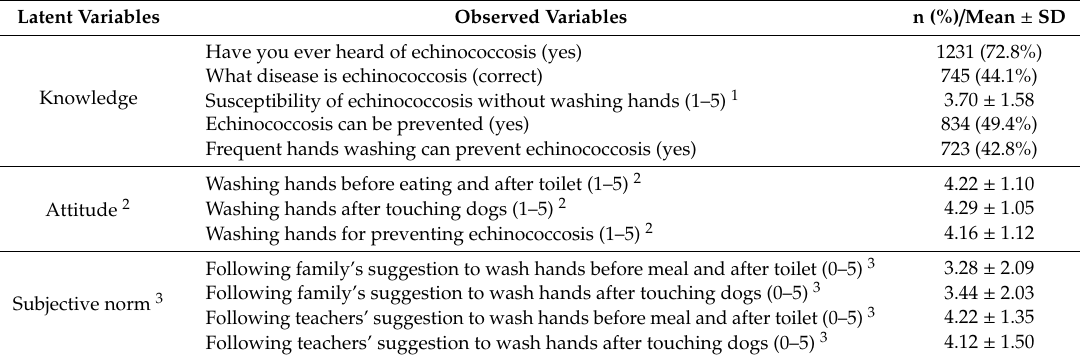
Table 2. Descriptive statistics for the variables utilized in the SEM (N =